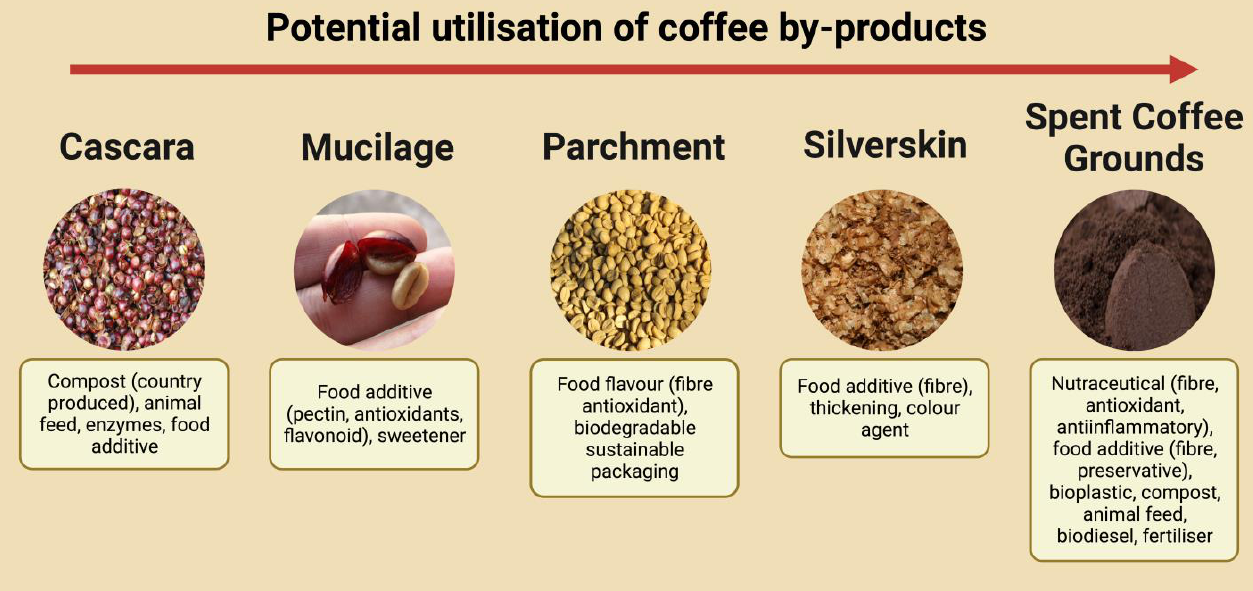
Figure 2. Coffee by-products and their potential applications. Data sourced from [14,17,18].